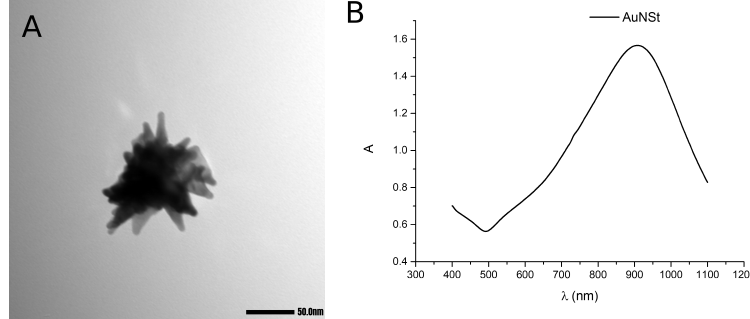
Figure 3. ( A ) Morphology of the gold NanoStar synthesis under electronic microscopy, and ( B ) mea- sured absorption spectrum. A.U. normalized at 400 nm ( ε = 2400 L mol − 1 cm − 1 for Au